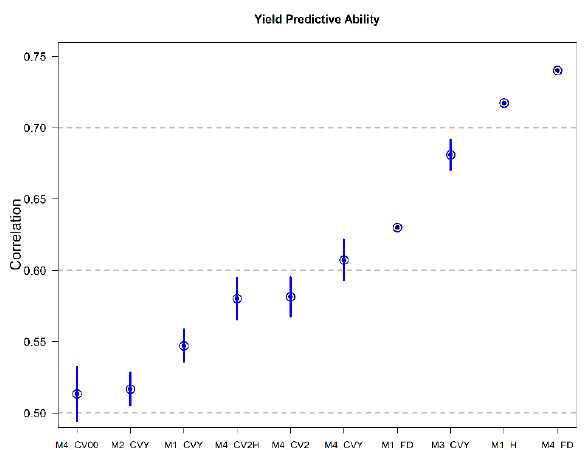
Figure 2. Square root of the heritability (H; M1_H), model goodness of fit under single-trait (M1_FD) and multi-trait (M4_FD) models, and mean predictive ability (20 replicates) and uncertainty interval of the mean plus minus the standard deviation for 7 different strategies for grain yield. M1_CVY, single-trait model using marker SNPs; M2_CVY, single-trait model using information of the AT as covariates; M3_CVY, single-trait model combining maker SNPs and phenotypic data of the AT; M4_CV00, multi-trait model for predicting fully untested genotypes; M4 _CV2; multi-trait model for predicting partially tested (50%) genotypes; M4_CV2H; multi-trait model for predicting partially tested (75%) genotypes; M4_CVY, multi-trait model for predicting partially tested genotypes for traits other than yield (100%).